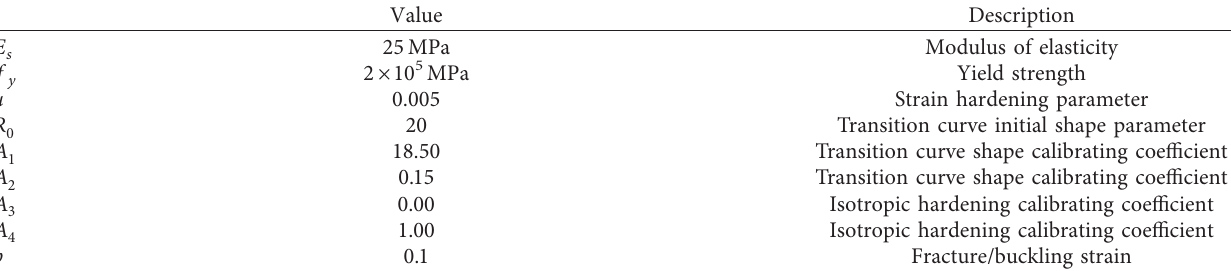
Table 2: Data required to generate the stress-strain curve of reinforcing